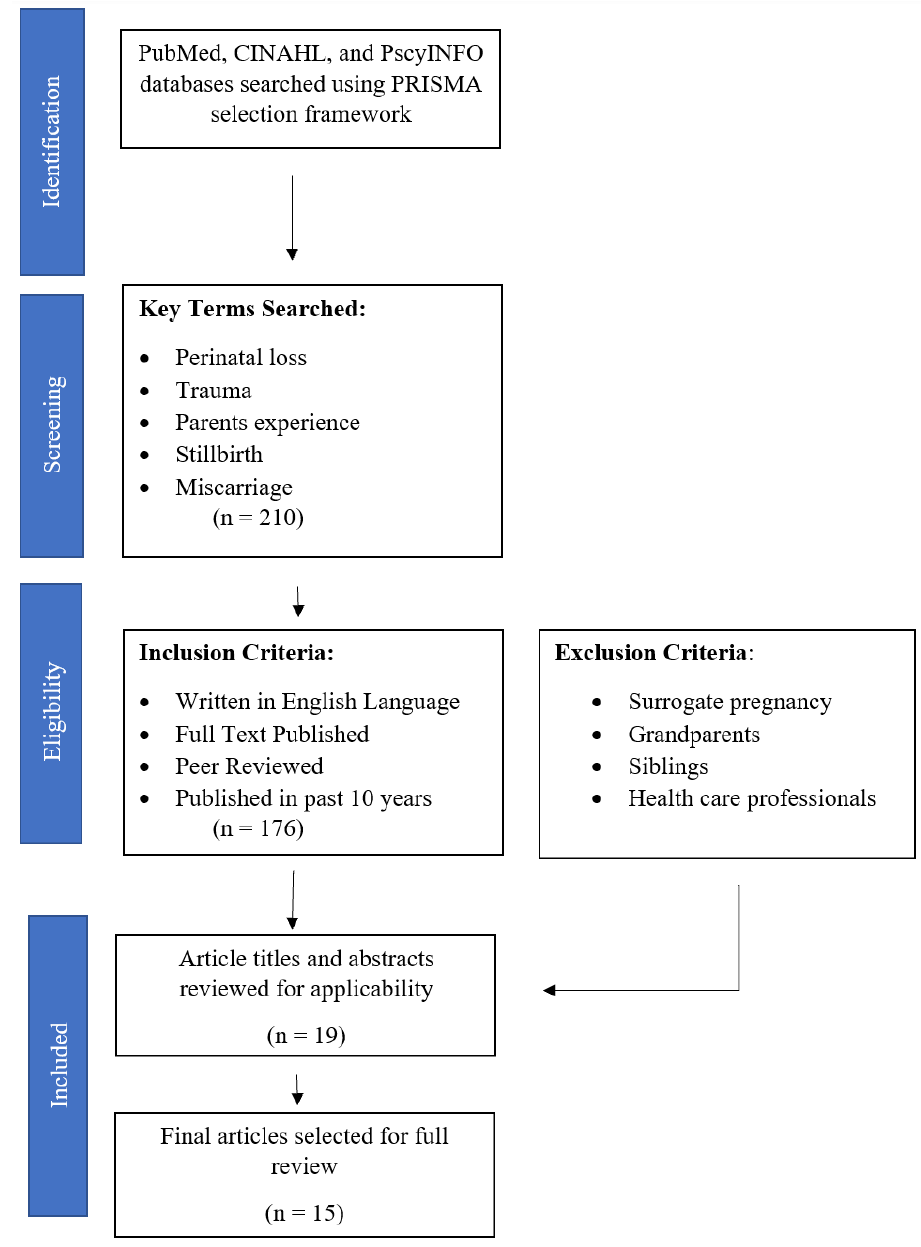
Figure 1. PRISMA-ScR flow diagram [15].